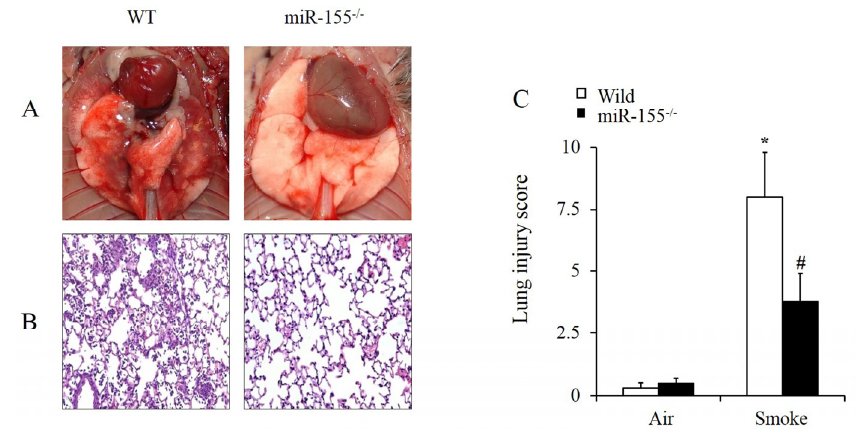
Figure 2. MiR-155 deficiency was associated with decreased smoke-induced lung injury. ( A ) At 12 h after smoke, pathological observation of the lungs in mice was performed. ( B ) Lung sections were stained with H&E, original magnification 200 × . ( C ) Lung injury scores were measured and calculated. n = 4 samples per group. * p < 0.05 vs. wild-type (WT) mice treated with air. # p < 0.05 vs. WT mice treated with smoke.